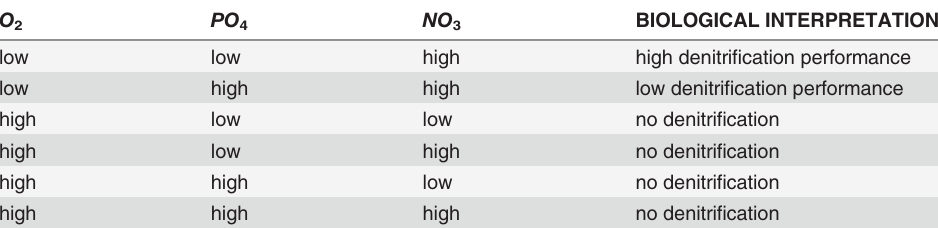
Table 2. Biological interpretation of the steady states of the system under different environmental